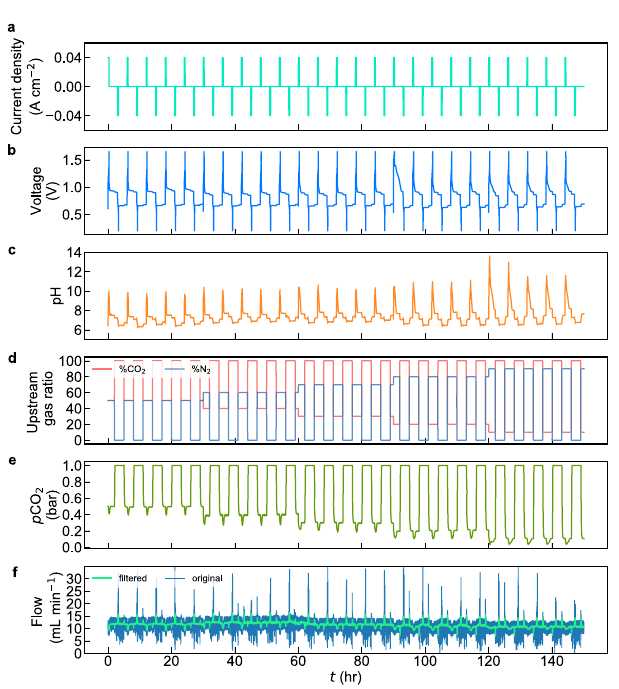
Fig. 3 Twenty fi ve CO 2 concentrating cycles with 0.5, 0.4, 0.3, 0.2, and 0.1 bar inlet pCO2 and 1 bar exit pCO2 at 40 mA cm − 2 . Same cell and negolyte as in Fig. 2 were employed . a Current density. b Voltage. c pH of the negolyte. d N 2 and CO 2 percentage in the upstream source gas, controlled by mass fl ow controllers; total pressure 1.0 bar. e